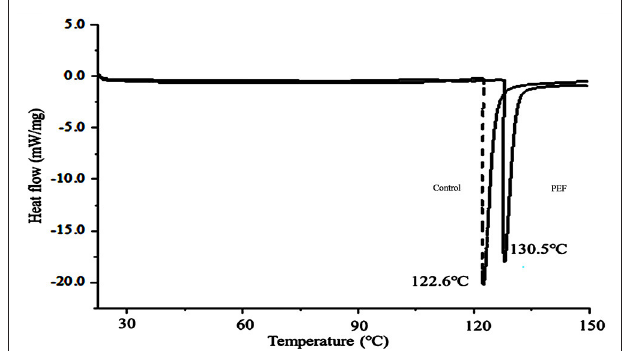
FIGURE 5 | The DSC analytical curve of the SDF from orange peel (solid line: treated by PEF, dotted line: untreated). PEF treatment parameters: electric field intensities 6.0 kV/cm, the number of pulses 30, the extraction time of 20min, liquid-solid ratios of 15:1 and temperature of 45 ◦ C.